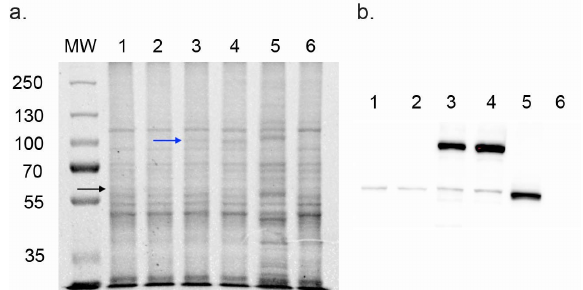
Figure 1. SDS-PAGE and Western blot analysis of CnCYP51-6×His and CnCPR-6×His. ( a ) Coomassie-stained SDS-PAGE gel of crude membranes (15 μ g of protein) expressing recombinant C. neoformans proteins. ( b ) Western blots of crude membranes (15 μ g/lane) decorated with mouse anti-6×His antibody and visualised using ECL. Lanes: 1. Cn1, 2. Cn2, 3. Cn3, 4. Cn4, 5. Y941, 6. Y1857 (AD2 Δ ). MW: 5 μ L protein molecular weight markers (PageRuler Plus Prestained Protein Ladder, Thermo Scientific, Waltham, MA, USA). Molecular weights are given in kDa. Blue arrow indicates the band for CnCPR and black arrow indicates CnCYP51.